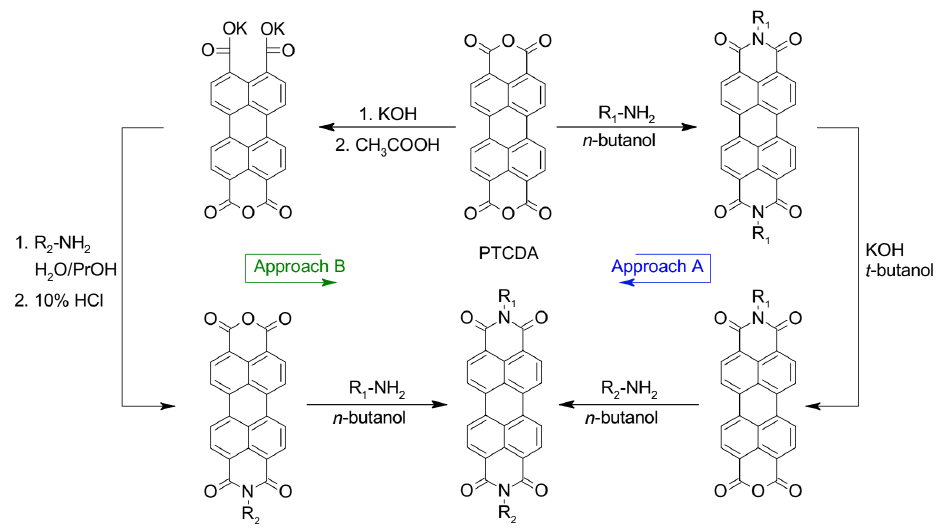
Scheme 2. Synthetic routes for the preparation of asymmetrical PDIs with different substituents on imide